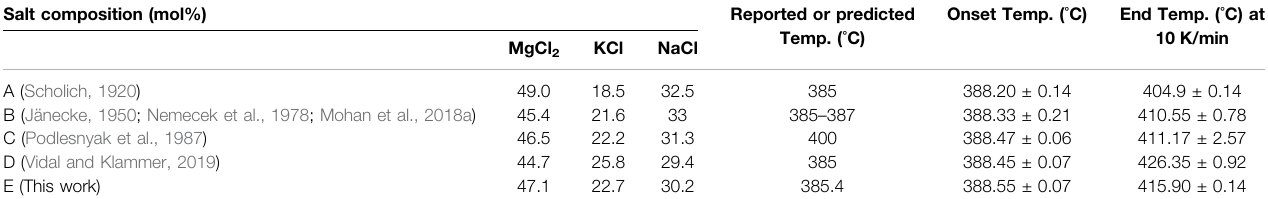
TABLE3| Comparisonofsaltcompositionsandmeltingtemperaturesofthestudied fi veMgCl 2 – KCl – NaClternarysaltmixturesexperimentallyobtainedbyDSCat10 ° C/min heating rate. The error of the measured temperatures is the standard deviation of three different measurements. Salt composition (mol%)